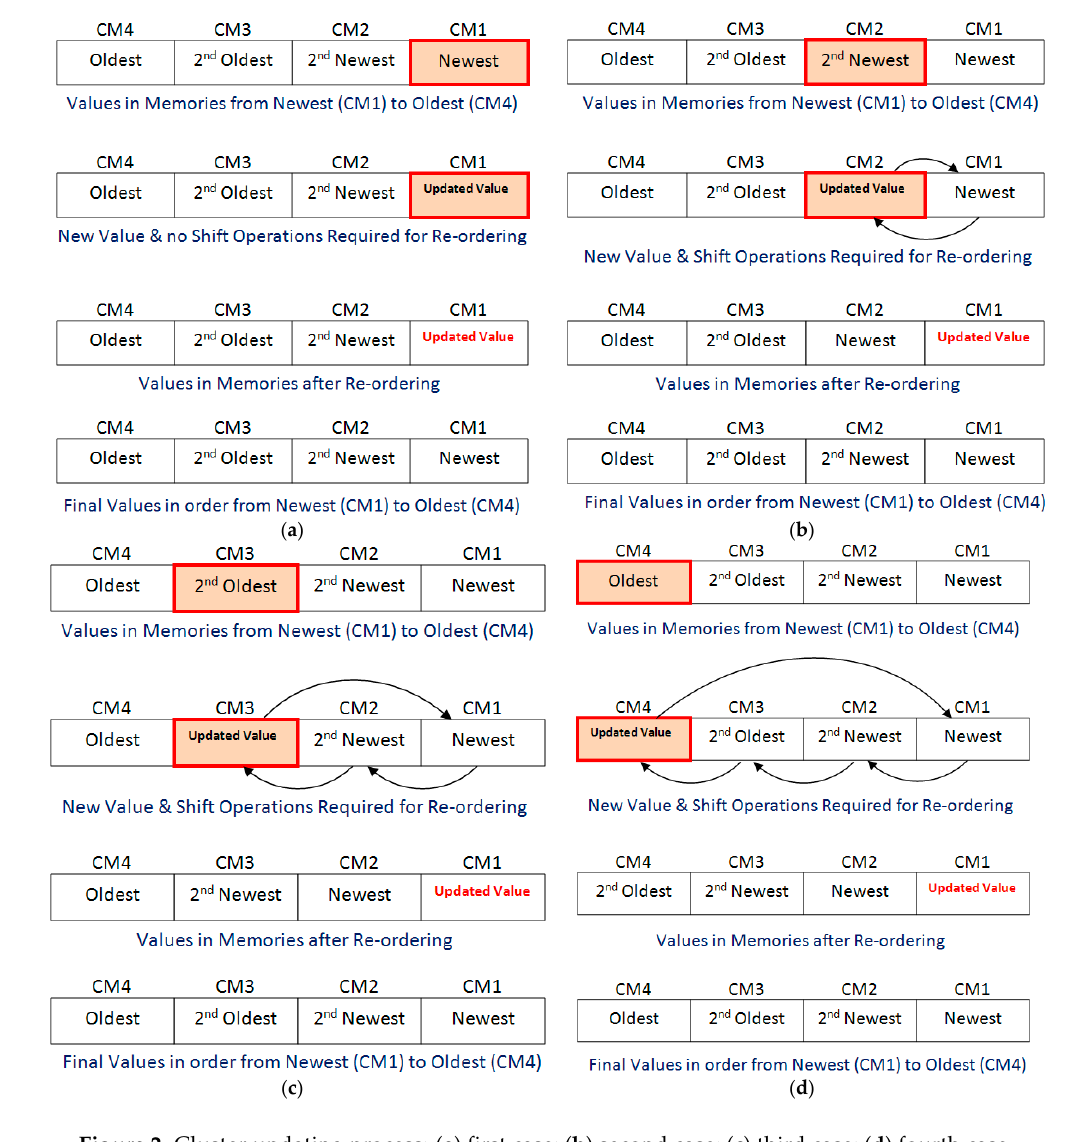
Figure 2. Cluster updating process: ( a ) first case; ( b ) second case; ( c ) third case; ( d ) fourth case.